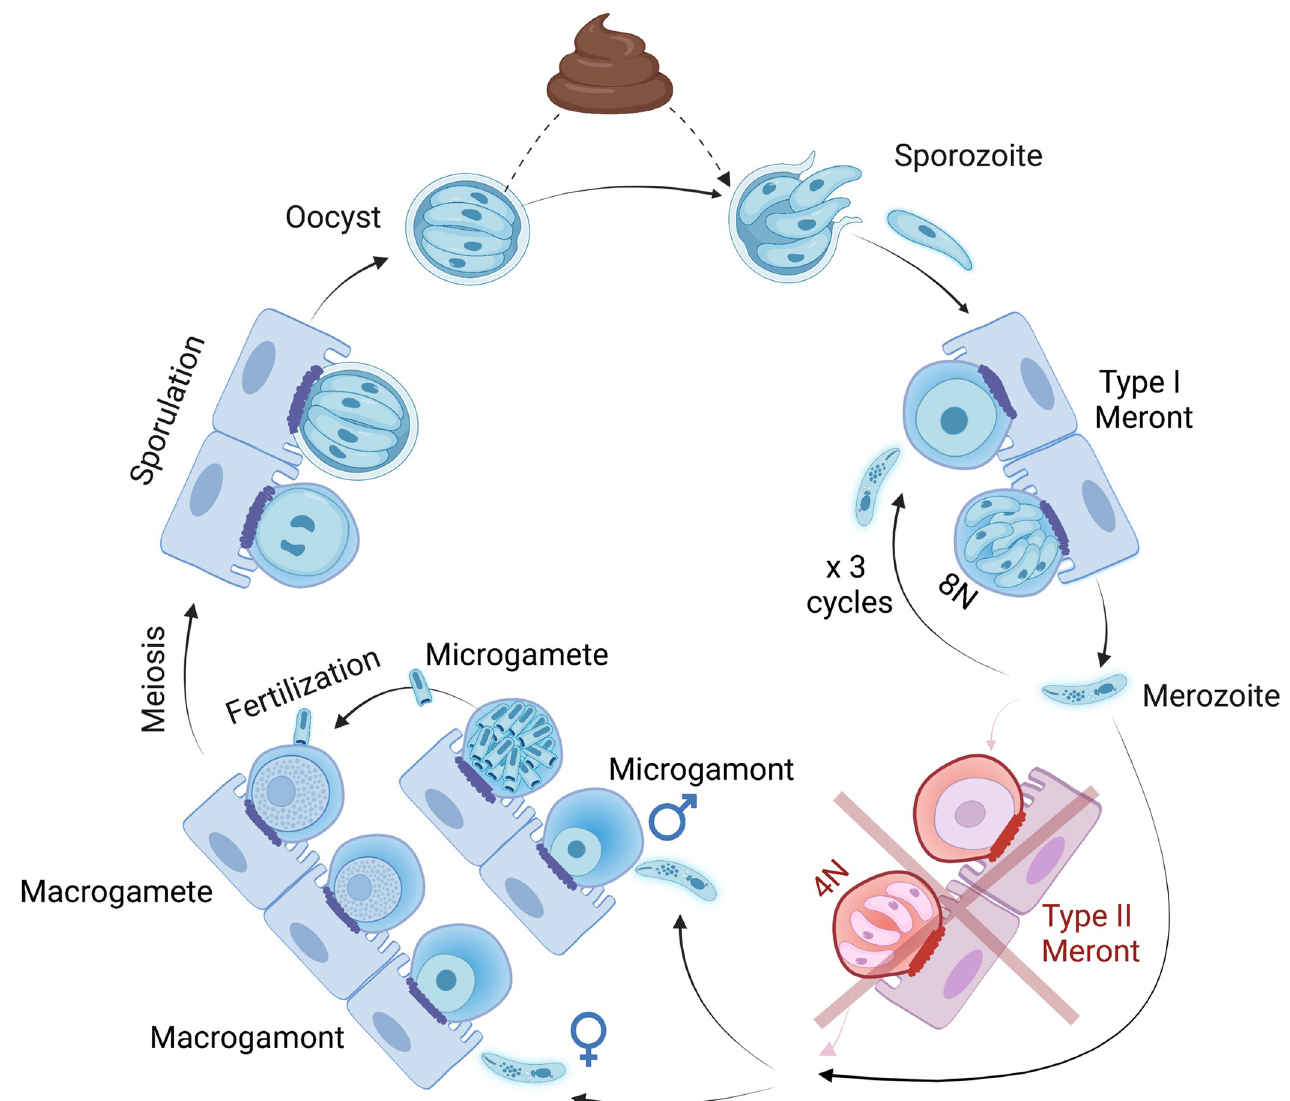
Fig 1. Cryptosporidium infection initiates by ingestion of environmentally robust oocysts, which contain 4 haploid sporozoites. Sporozoites excyst in the intestine and infect enterocytes in the intestinal epithelium. Here, parasites establish and are enclosed within a parasitophorous vacuole membrane and are separated from remainder of the host cell by an electron dense boundary. Division of this form (hitherto known as a type I meront ) generates 8 merozoites (perhaps 6 in some other Cryptosporidium species), which egress and reinfect adjacent enterocytes where they each create 8 more merozoites. At the third such cycle, parasites differentiate into sexually committed merozoites that reinfect a new enterocyte to form a male or female gamont . A second proliferative cycle, involving a type II meront that produces 4 merozoites, was previously believed to be required for the generation of sexually committed parasites, but English and colleagues [4] find that no such form exists in their system in C . parvum . Male microgamonts undergo repeated mitotic divisions to each produce 16 microgametes , and subsequent fertilization between a microgamete and a female macrogamete results in a diploid zygote that undergoes meiosis to create 4 new haploid sporozoites. These sporozoites are encapsulated in an oocyst that can either be shed into the environment or can excyst to autoinfect the same host. Both thick- and thin-walled oocysts have been described microscopically, and some research suggests that only thick-walled oocysts are environmentally